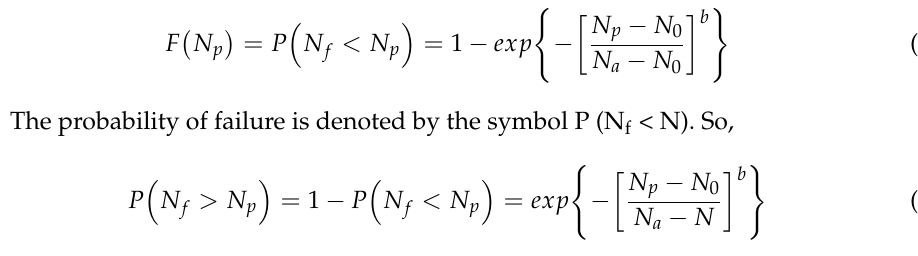
Figure 11. Normal probability plots of the results at the failure stage for mixtures ( a ) NC ( b )